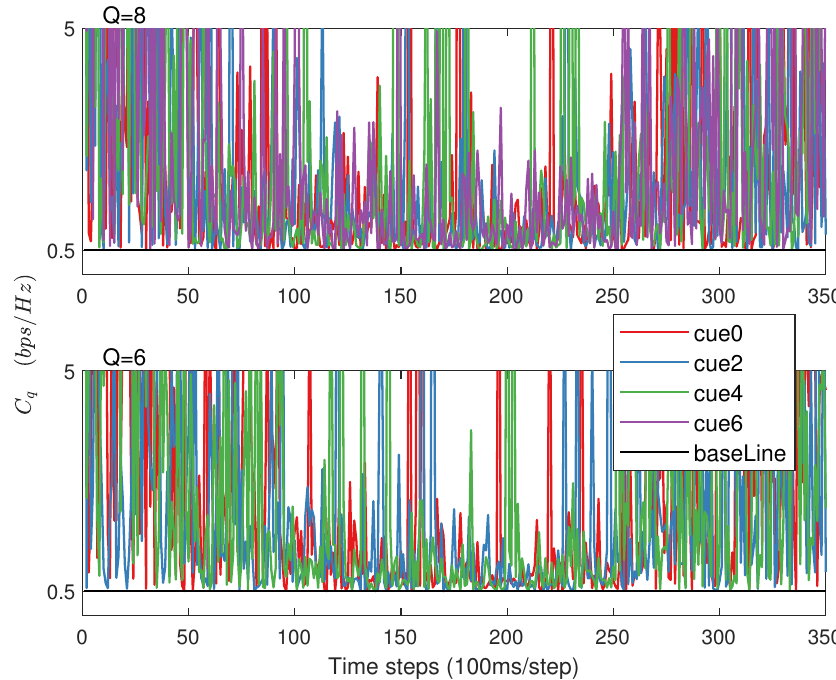
Figure 6. The ergodic capacities of CUEs when the resource allocation period is 100